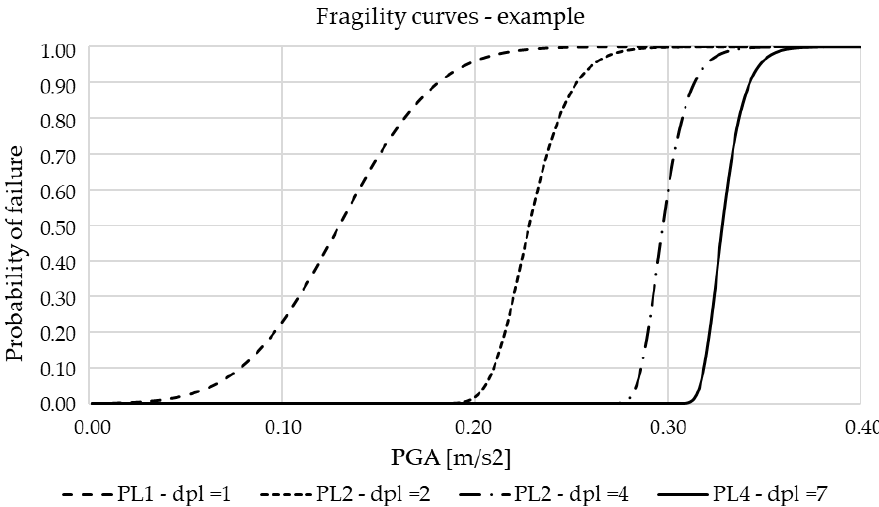
Figure 1. Example of fragility curves for bridge piers without adequate seismic capacity.